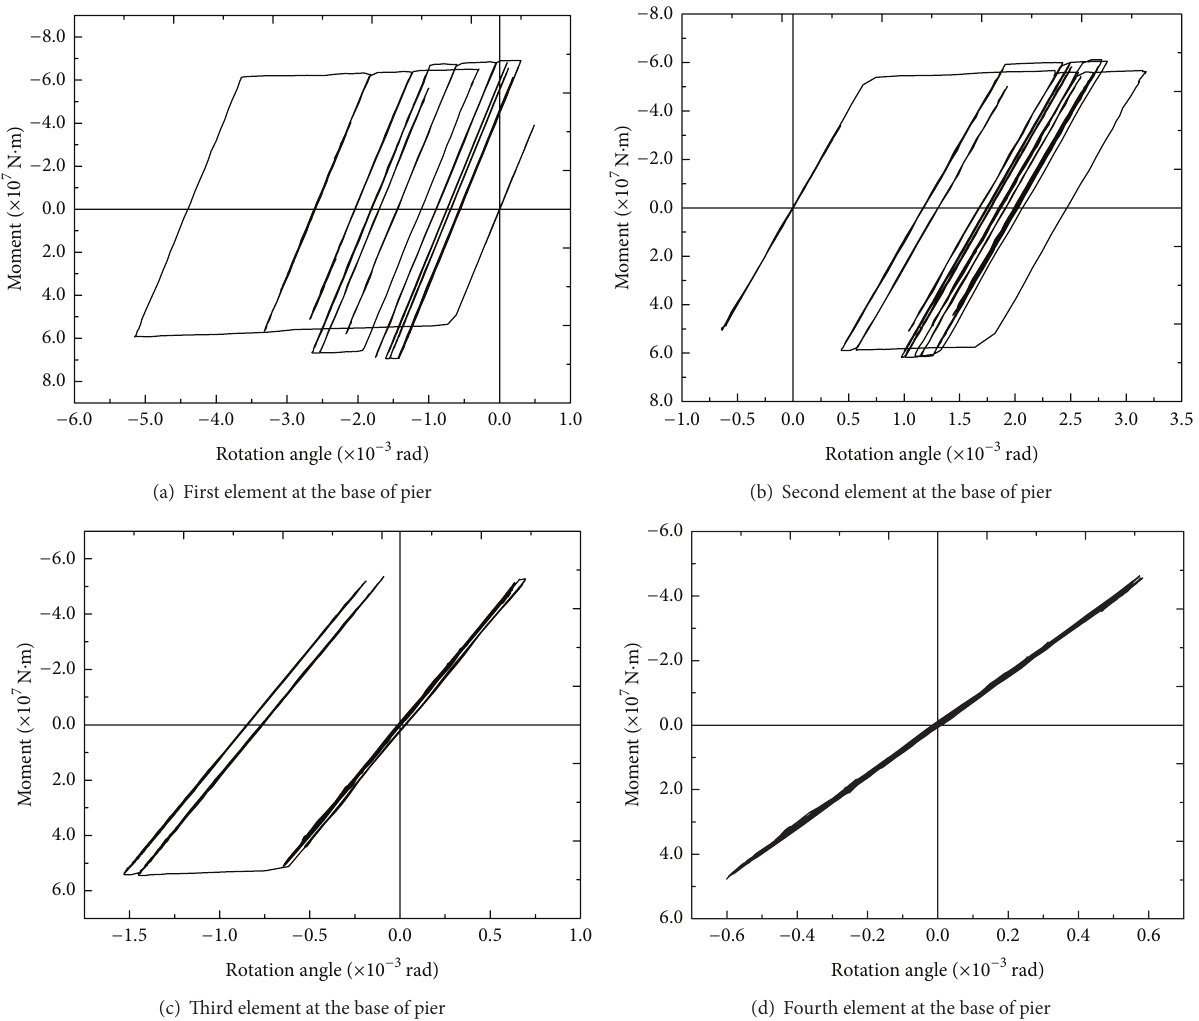
Figure 14: Moment-rotation relationship at the element of pier bottom for lateral near-fault ground motion record of Northridge-Rinaadi station with 350 km/h vehicle speed and 14m